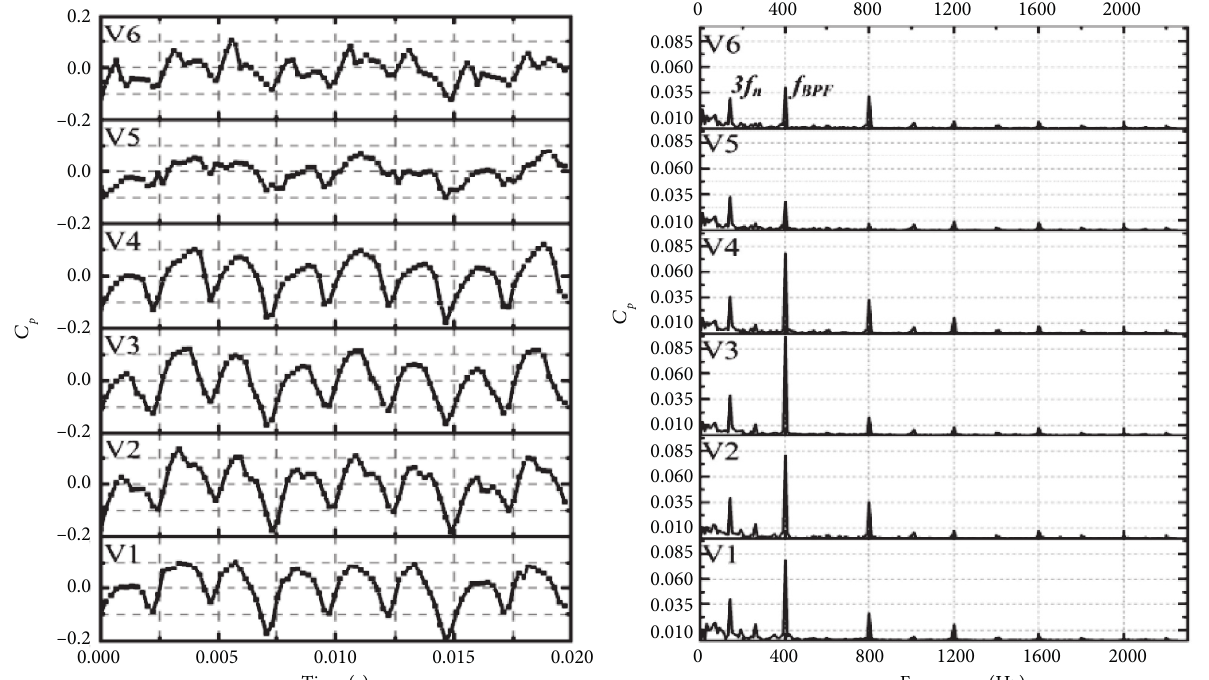
Figure 13: Time and frequency domains of the pressure pulsation at monitoring points V1–V6.